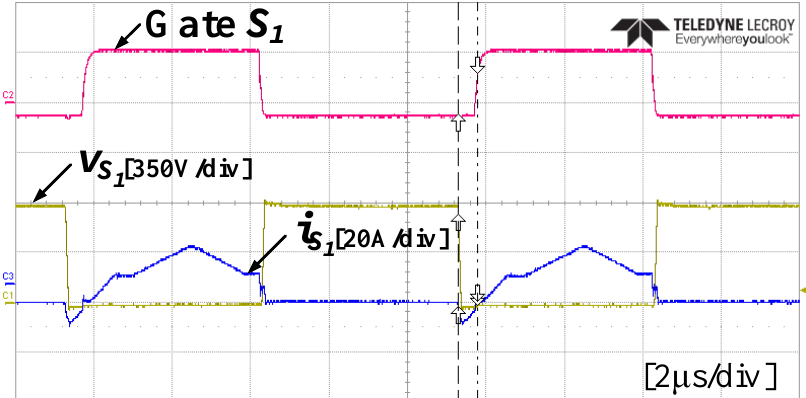
Figure 20. Switching experimental waveforms.